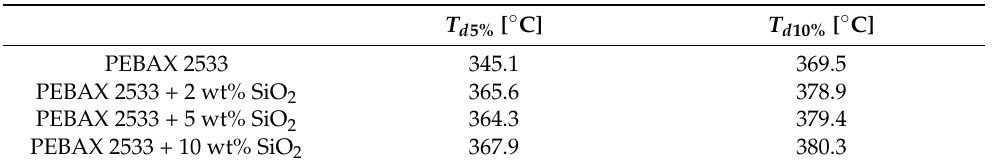
Table A2. Temperatures at which the weight of the sample decreases by 5 wt% and 10 wt% for a membrane containing different concentrations of SiO 2 .